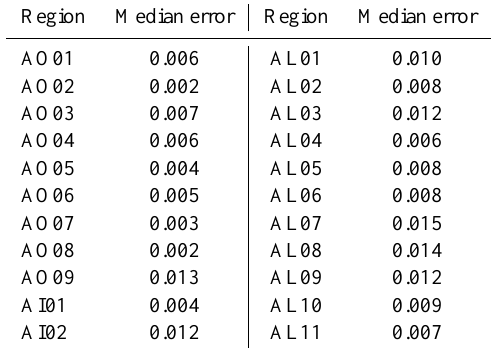
Table 2. The median sampling error in monthly mean AOD from MODIS when sub-sampled to resemble AATSR